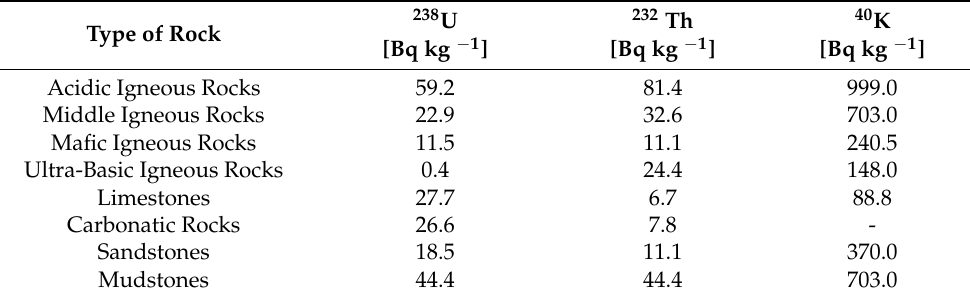
Table 1. Radionuclides Concentrations in Rocks